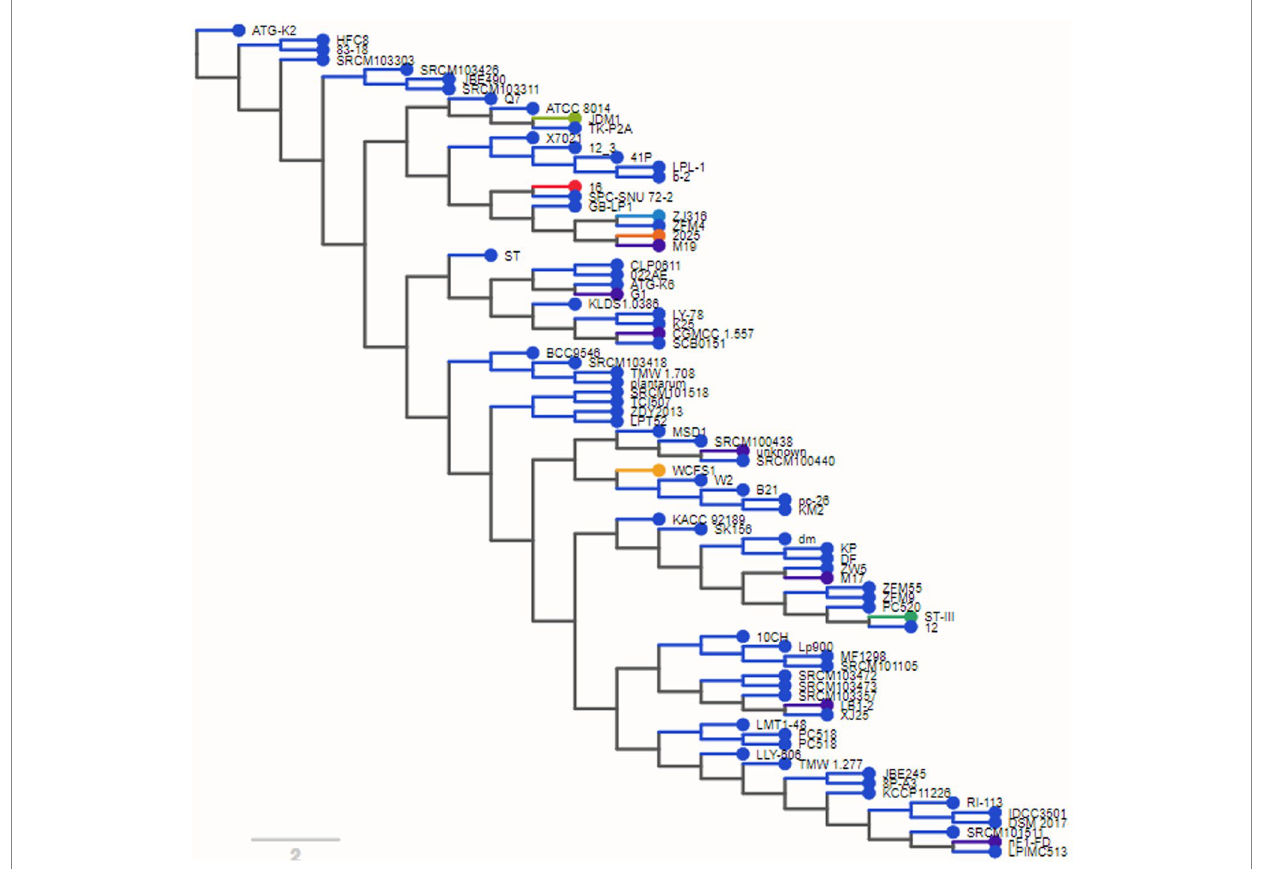
FIGURE 2 Phylogenetic tree shows genomes into clusters according to their taxonomic analysis.